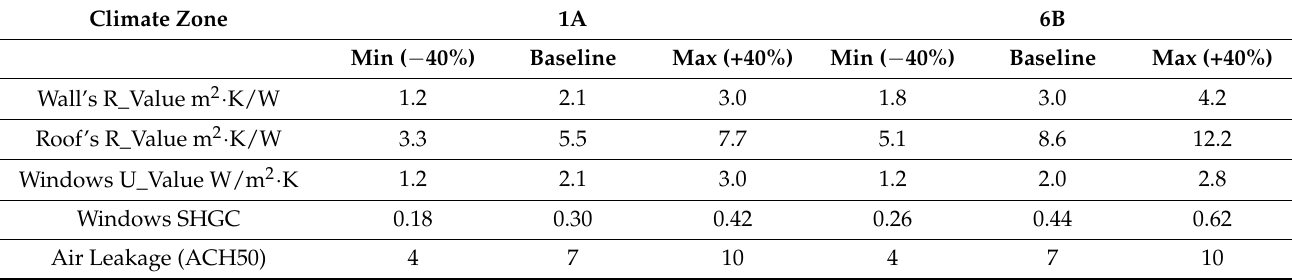
Table 8. The range of retrofit measures used in the sensitivity